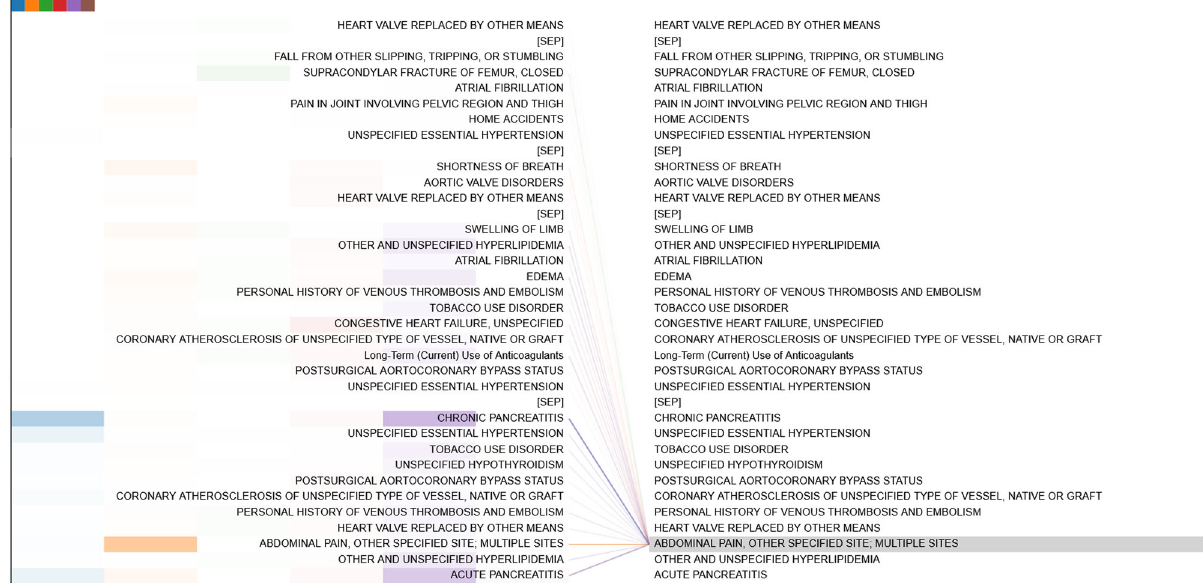
Fig. 7 Example of the dependency connections in the PaCa-Cerner cohort. Connection lines from the code in the left panel to the code in the right panel indicate attentions of the Med-BERT model. Color of the line indicates individual attention head, and intensity of the line indicates attention